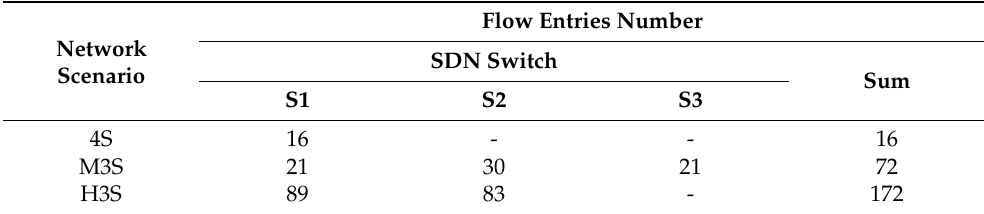
Table 2. Flow Entries Generated for Network Scenarios.